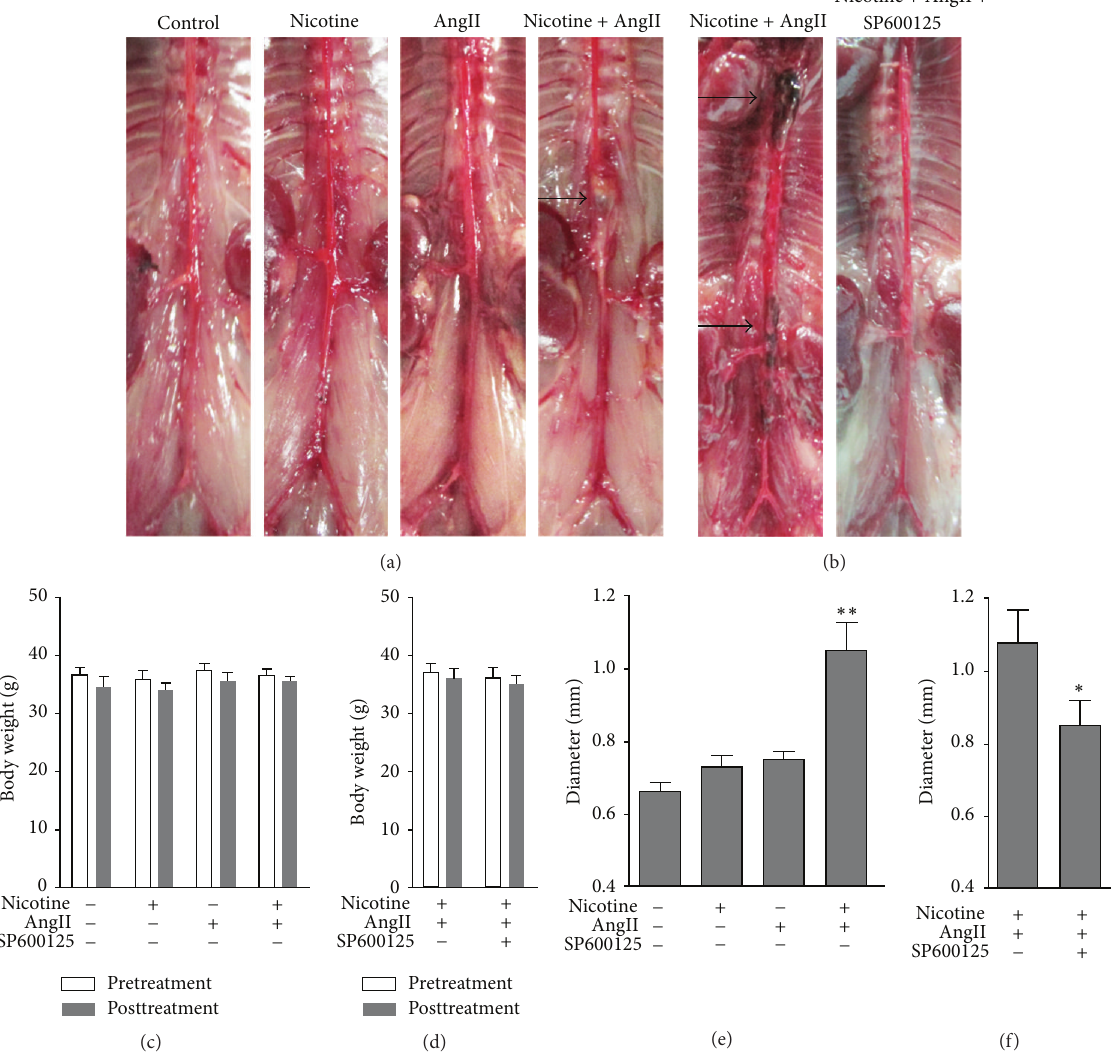
Figure 2: SP600125 attenuates the formation of aortic aneurysm induced by nicotine plus AngII. (a) Representative photomicrographs of abdomens of mice of all four experimental groups. No aortic aneurysms were detected in saline-, nicotine-, or AngII-treated groups. Nicotine plus AngII induced the formation of aortic aneurysms (published in Experimental & Clinical Cardiology [14]). (b) Representative photomicrographs of abdomens of the mice in the cotreatment and SP600125-supplemented groups. Nicotine plus AngII induced the formation of aortic aneurysms. No aortic aneurysms were detected in the SP600125 group. (c, d) In all experimental groups, the body weight did not change from initiation to the end of the experiment. (e, f) The maximum diameter of the suprarenal abdominal aorta was measured using ImageJ and normalized to the body surface area, which was calculated using the Meeh–Rubner formula (area = 𝐾(𝑊 ∧ (2/3))/1000 , 𝑊 : weight, 𝐾 = 9.1 ). Data are represented as the mean ± SEM. ∗ 𝑃 < 0.01 versus nicotine or AngII group; ∗∗ refers to 𝑃 < 0.01 versus control group. AAA, abdominal aortic